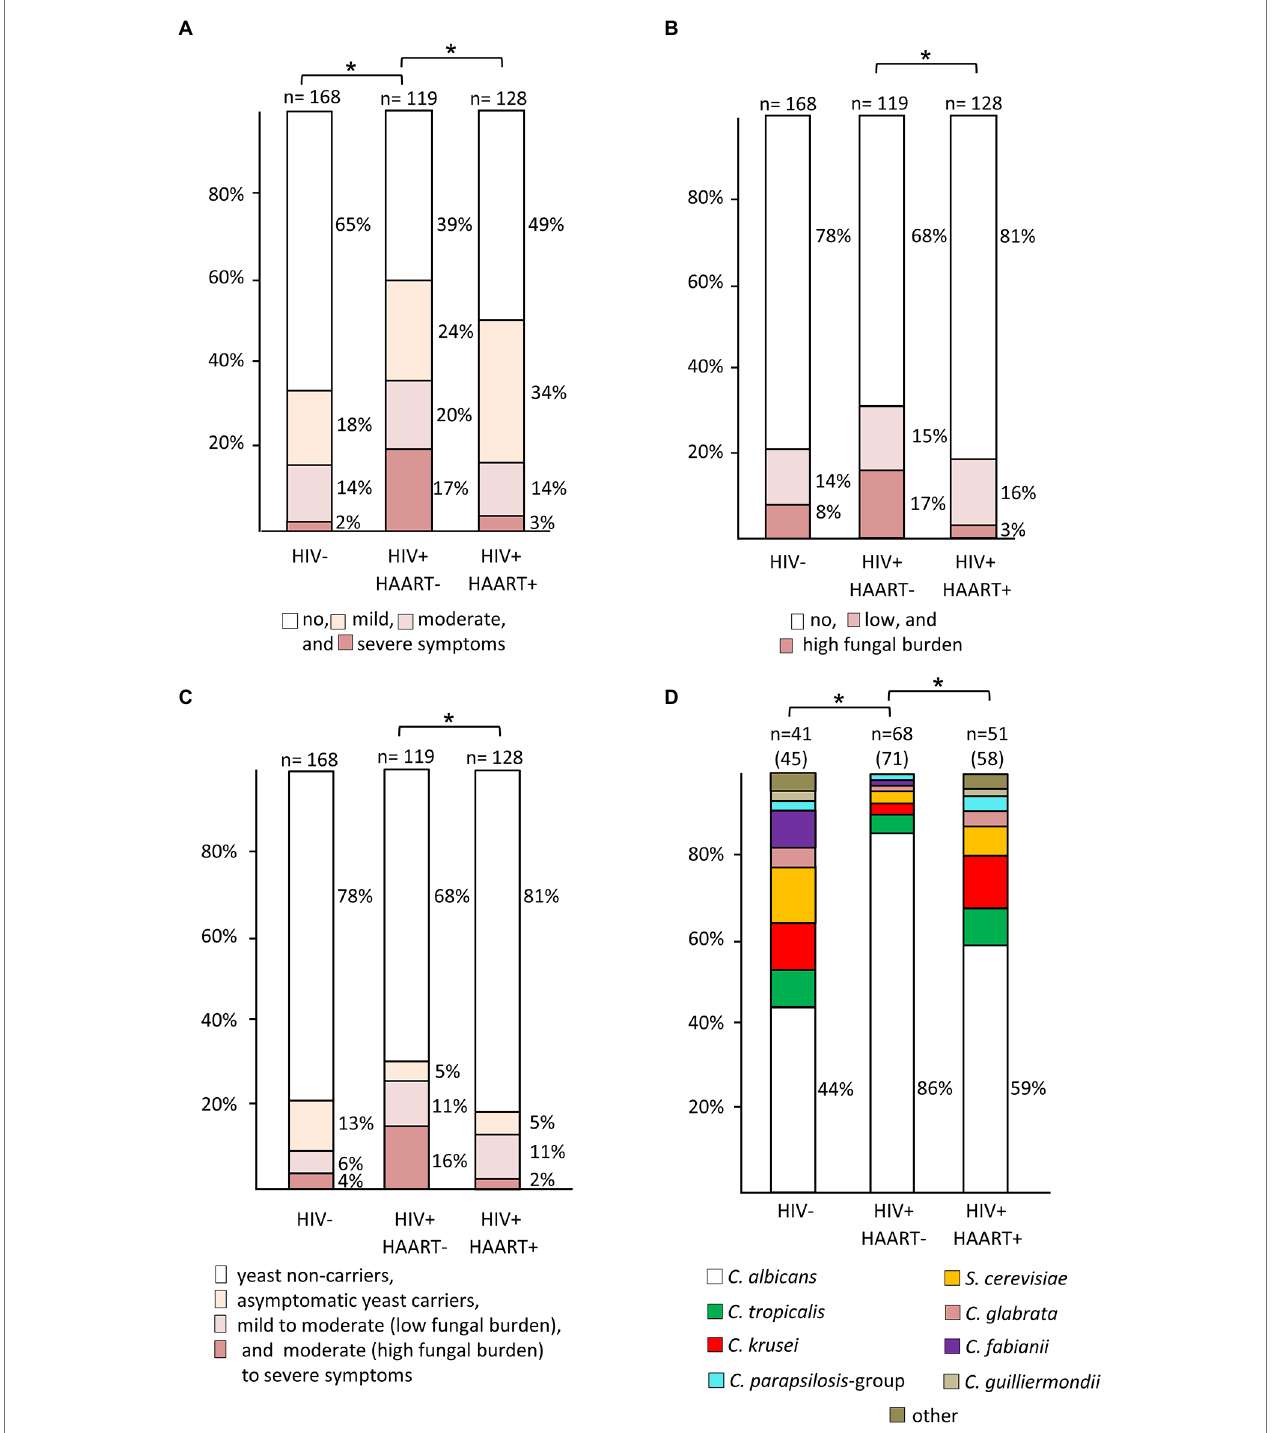
FIGURE 3 | Prevalence rates of yeast species among patient groups with different HIV and treatment status. (A) Rates and degree of oral symptoms (* indicates significant differences in prevalence of moderate-to-severe symptoms), (B) rates and degree of oral yeast colonization (* indicates significant differences in prevalence of a high yeast burden), (C) association of oral colonization with disease symptoms (* indicates significant differences in moderately to severely symptomatic yeast carriers), and (D) species distribution derived from yeast-positive swabs. In panels (A – C) , numbers above columns indicate size of patient subgroups. a: Y-axis of panel (D) is scaled to total number of isolates, given in parentheses after number of swabs. Due to mixed-species colonization the number of isolates can exceed number of swabs (* indicates significant differences in prevalence rates of Candida albicans